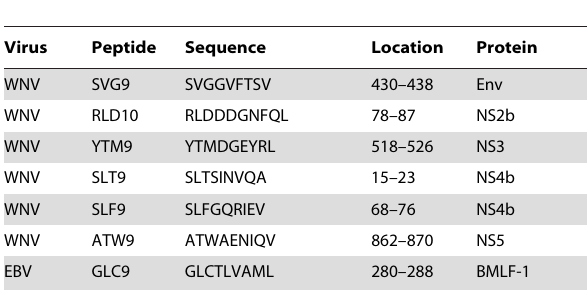
Table 1. Epitopes used to probe WNV specific